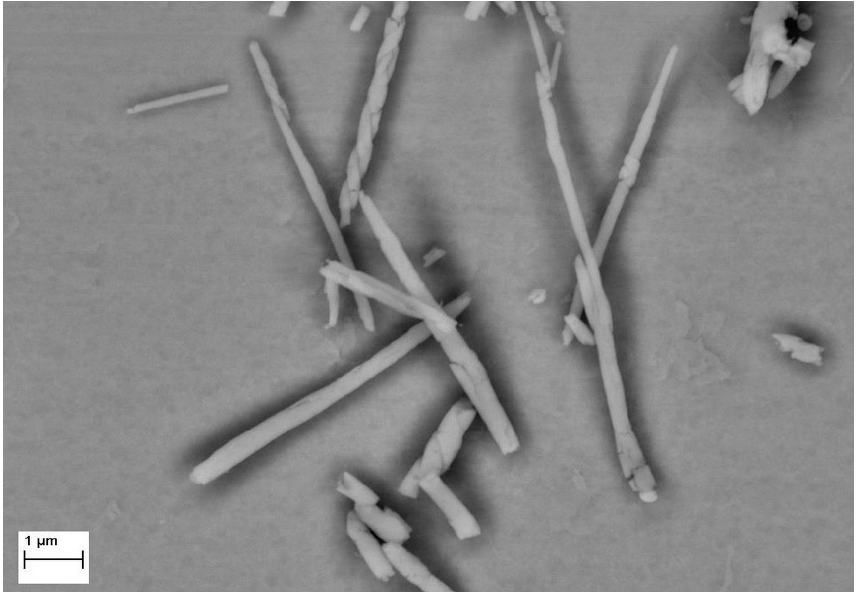
Figure 10. Detail of wear debris on the worn surface of sample TaAlN3.